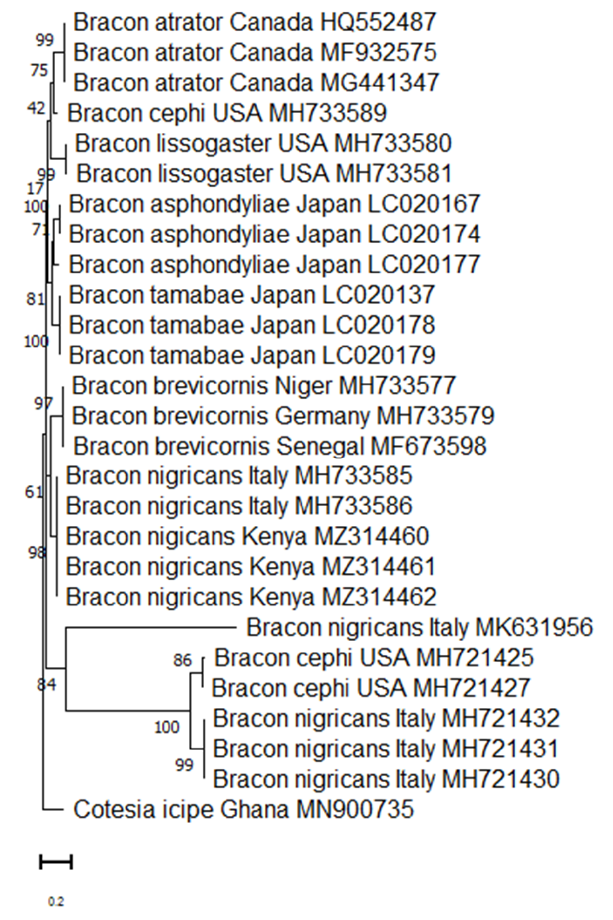
Figure 1. Maximum likelihood phylogenetic tree for the mitochondrial COI sequences of Bracon species from GenBank together with the specimen Bracon nigricans identified in our